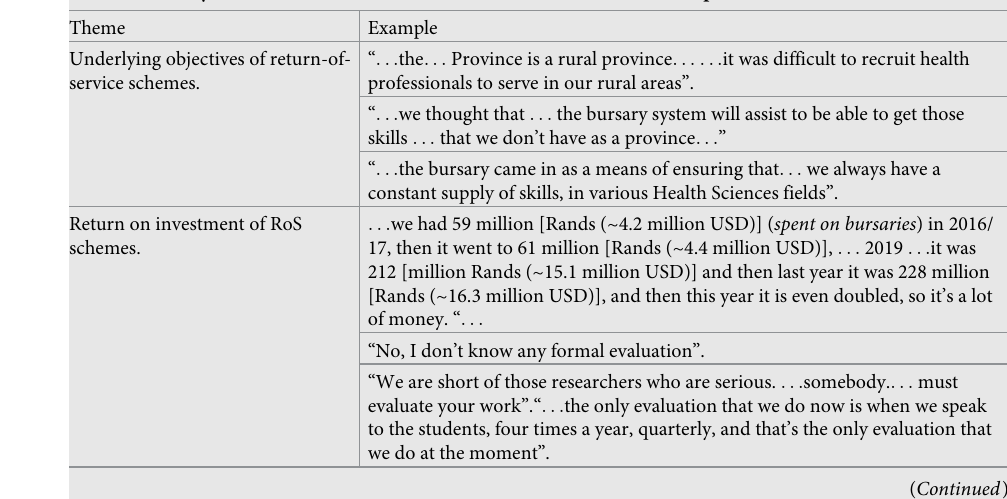
Box 1. Summary box on return-of-service schemes in selected South African